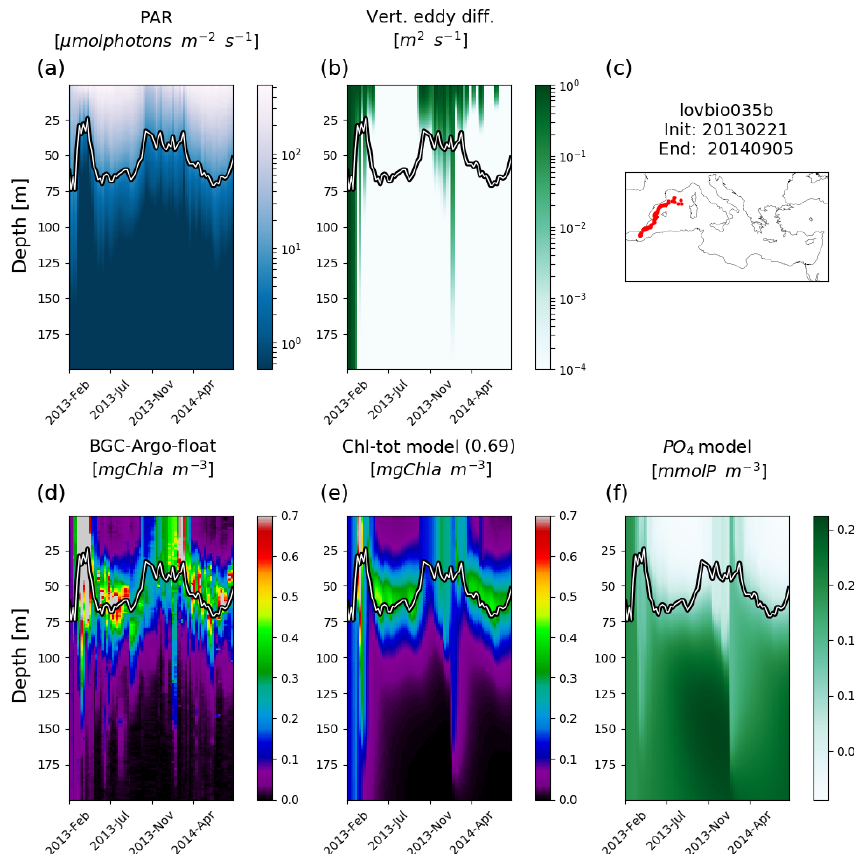
Figure 4. As Fig. 3 but for the BGC-Argo float lovbio035b (WMO code